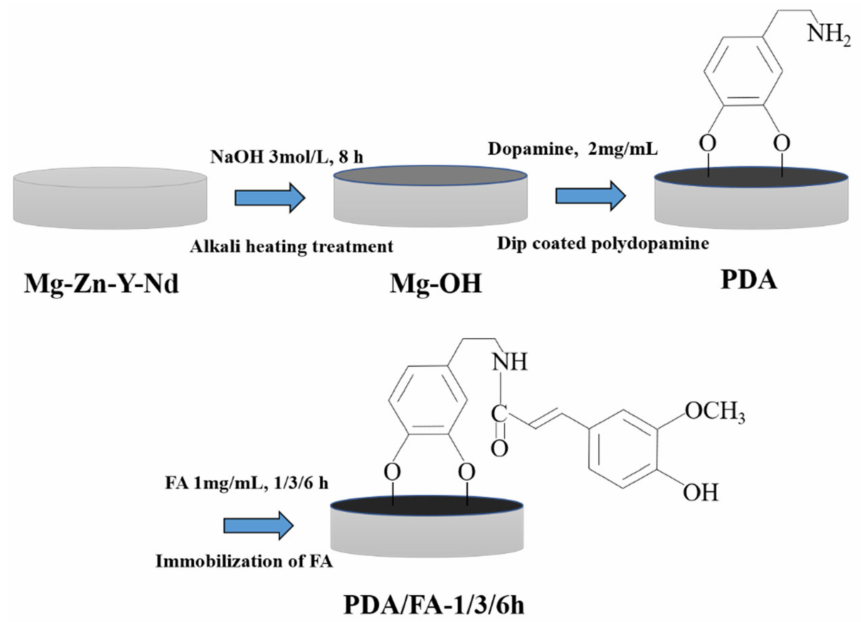
Figure 1. The scheme for preparing Mg-OH/PDA/FA composite